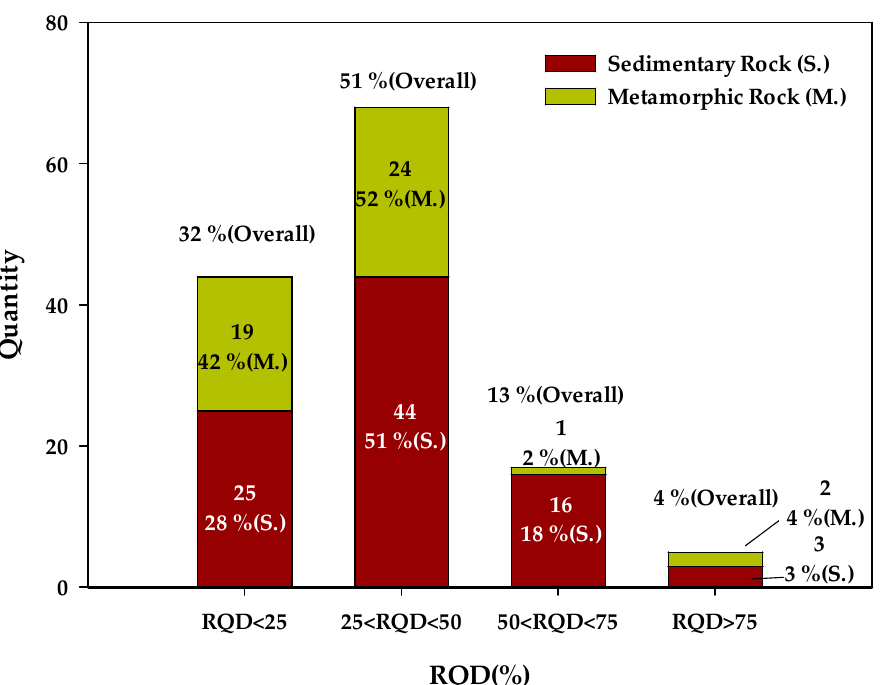
Figure 3. Quantity distribution of different rock-quality designation (RQD) levels for the samples of n > 2.25.